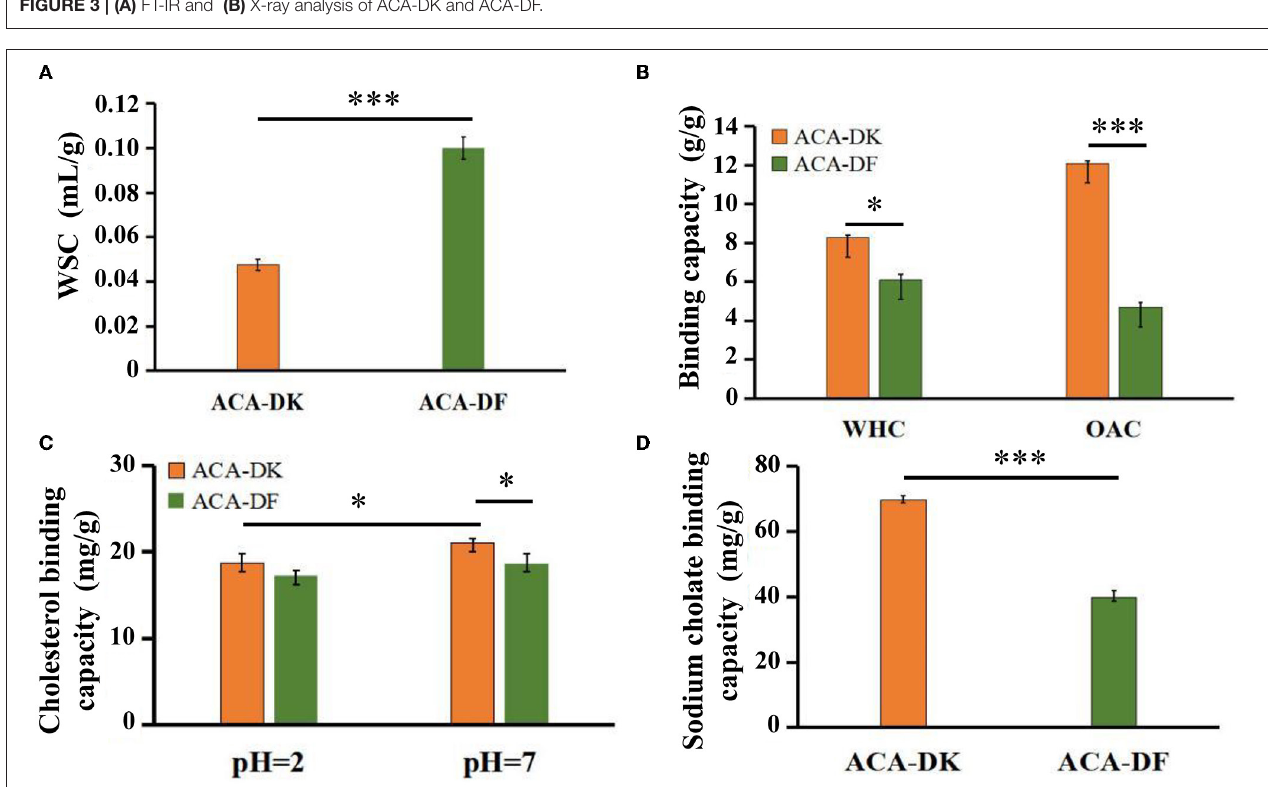
FIGURE 4 | Physicochemical and functional properties of ACA-DK and ACA-DF. (A) Water swelling capacity (WSC); (B) water holding capacity (WHC) and oil binding capacity (OBC); (C) cholesterol binding capacity (CBC) at different pH; (D) sodium cholate binding capacity (SCBC). Results of experiments are express as mean ± SEM for each experimental group ( n = 3). Significant differences were compared with each two groups (* P < 0.05, *** P < 0.001).